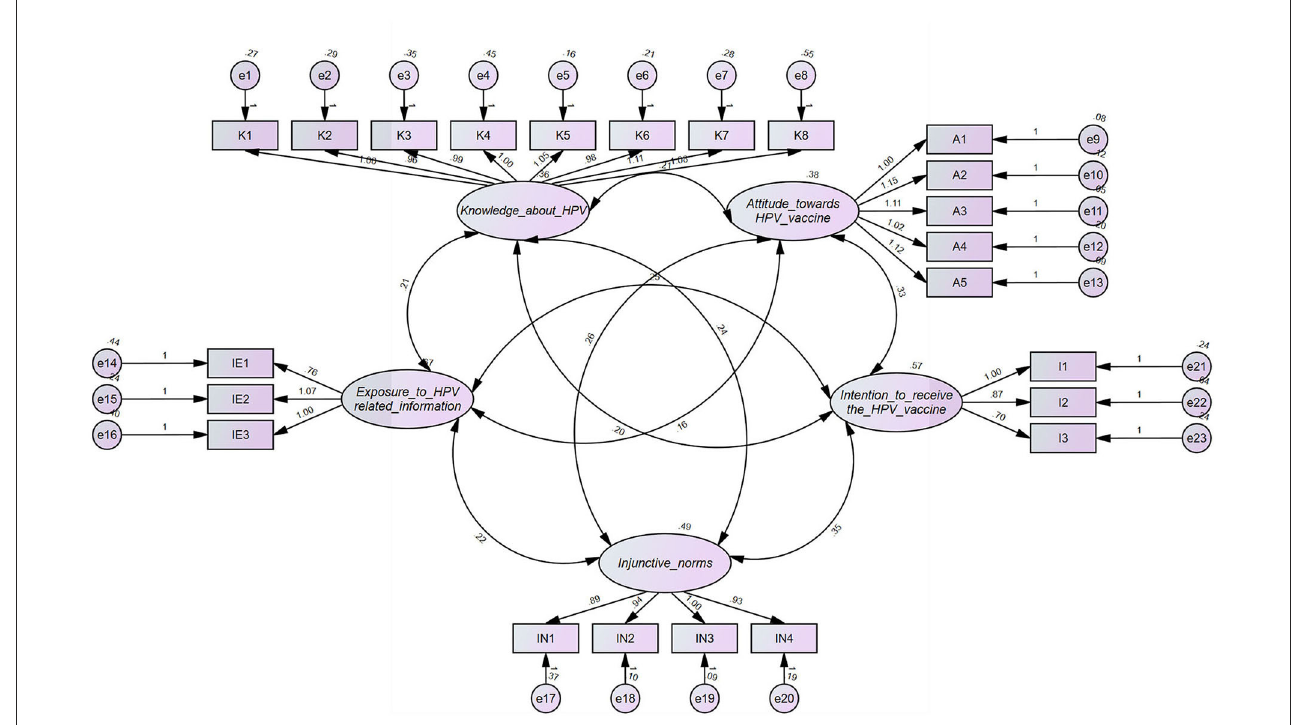
FIGURE2 Confirmatory factor